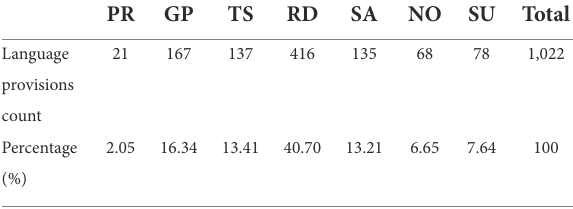
TABLE 2 Distribution of language provisions across